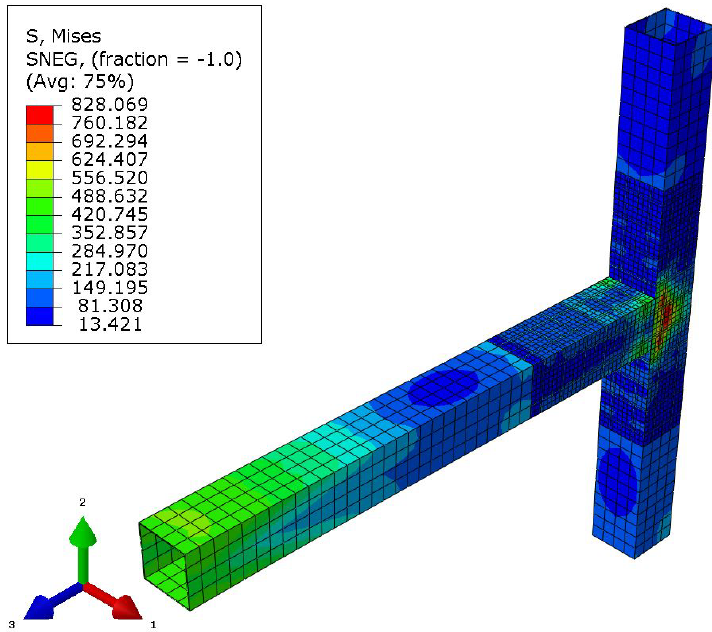
Figure 7. Contour plot of the Von-Mises for the CFRP strengthened connection .